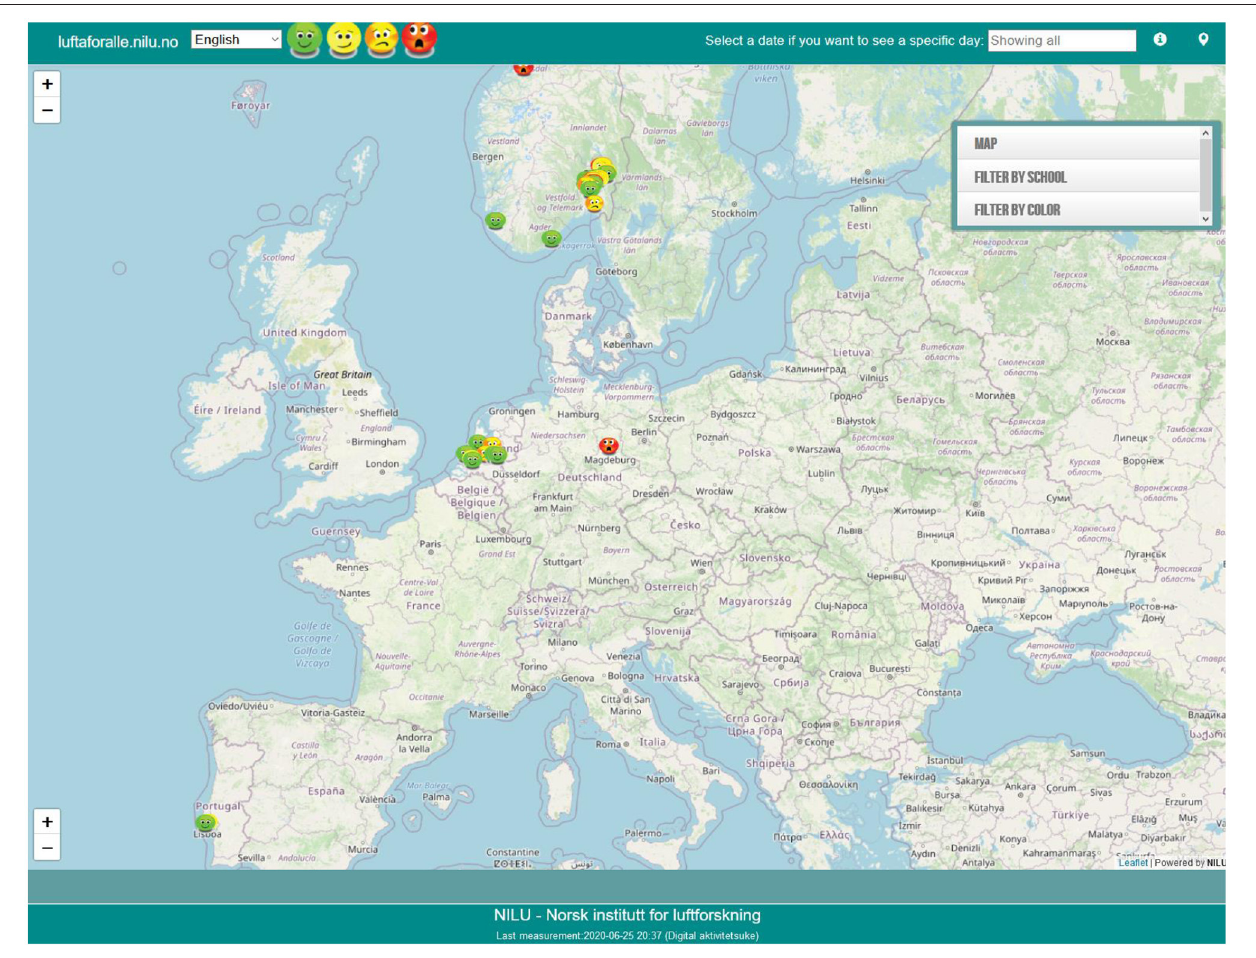
FIGURE 5 | Screen shot of the web portal where the schools can upload the data and visualize the results from all the participant schools.